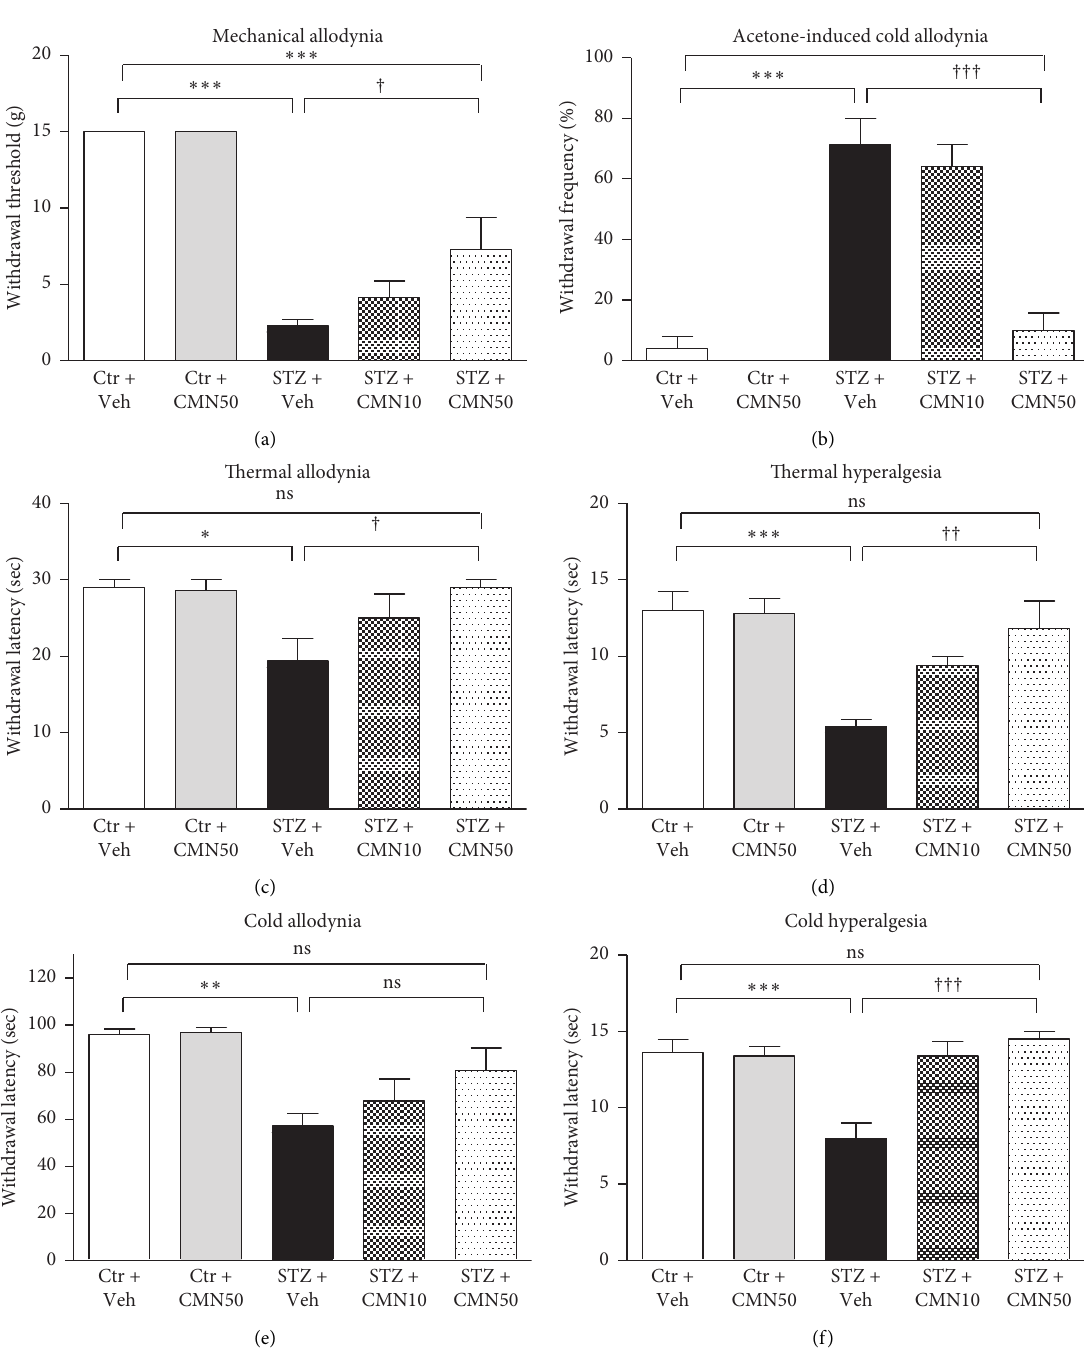
Figure 2: Effects of curcumin (CMN) administered orally on the diabetic neuropathic painful behavior induced by streptozotocin (STZ). STZ (50mg/kg) was intraperitoneally injected to induce diabetic neuropathy in rats. After 4 weeks, rats were treated orally with vehicle and either 10mg/kg/day or 50mg/kg/day of CMN for 4 consecutive weeks. One day after final drug administration, behavioral tests were performed to measure responses to mechanical (a), acetone-induced cold (b), thermal ((c) 42 ° C and (d) 50 ° C), and cold ((e) 10 ° C and (f) 4 ° C) stimuli ( n � 10 animals per group, one-way ANOVA with Bonferroni post hoc). ∗ p < 0 . 05, ∗∗ p < 0 . 001, and ∗∗∗ p < 0 . 001 compared to the Ctr+Veh group. † p < 0 . 05, †† p < 0 . 01, and ††† p < 0 . 001 compared to the STZ+Veh